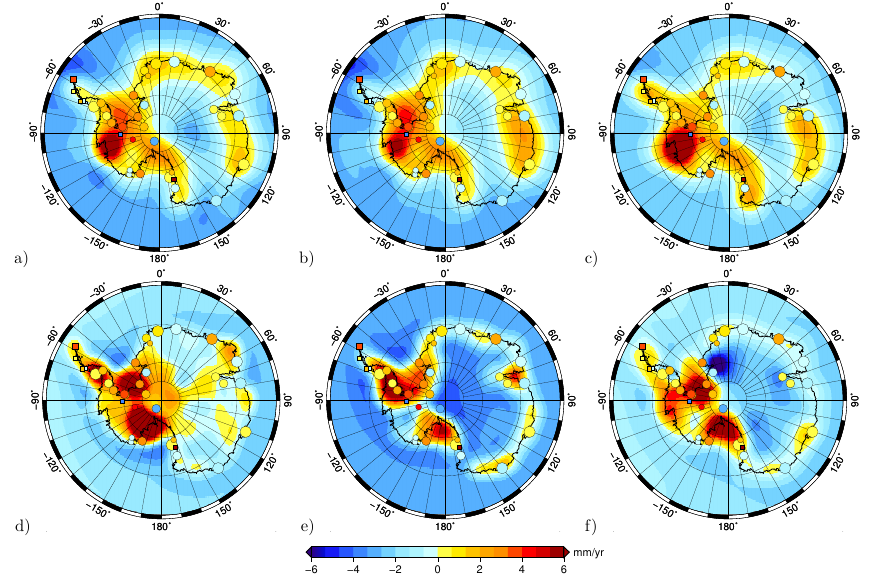
Fig. 10. Comparison of the 35-station WRMS of the residuals between the vertical rates from the GPS stations and the uplift rates derived from the following empirical/modeled cases: (a) CSR RL04 DDK3, (b) CSR RL05 Reg, (c) DMT-1b, (d) ICE-5G, (e) IJ05, and (f) W12a. Note that, for these comparisons, a systematic bias is removed from the empirical/modeled rates with respect to the GPS network (see text for